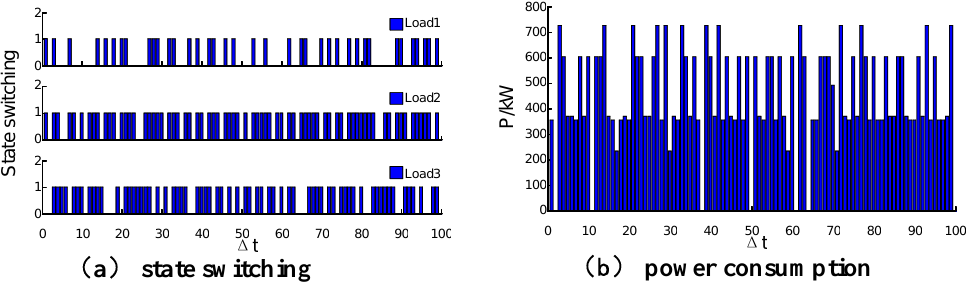
Figure 15. The state switching and power consumption of distributed control; ( a ) state switching; ( b ) power consumption.